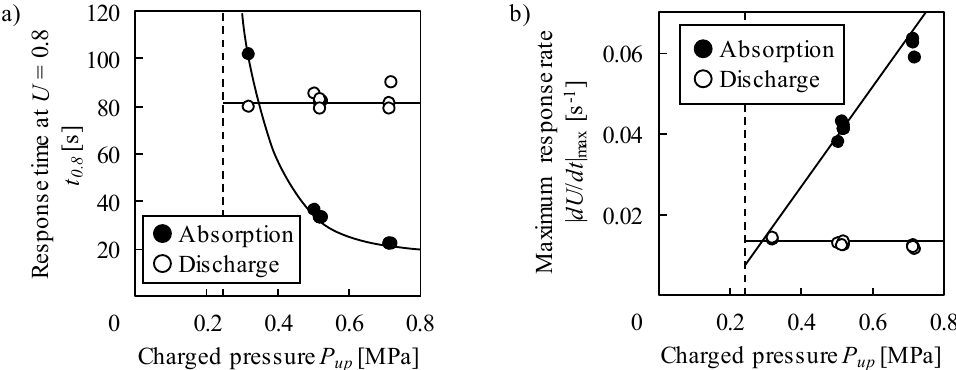
Figure 3. Dependence of ( a ) response time at U = 0.8 and ( b ) maximum response rate on pressure. Dashed lines represent the phase transition pressure during absorption.